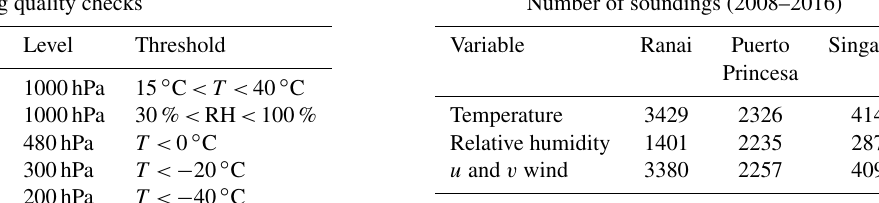
Table 1. Quality control flags enacted during the sounding dataset creation as a first pass at removing erroneous soundings or raw data decoding. This is not a comprehensive list, as additional subjective quality control was applied.